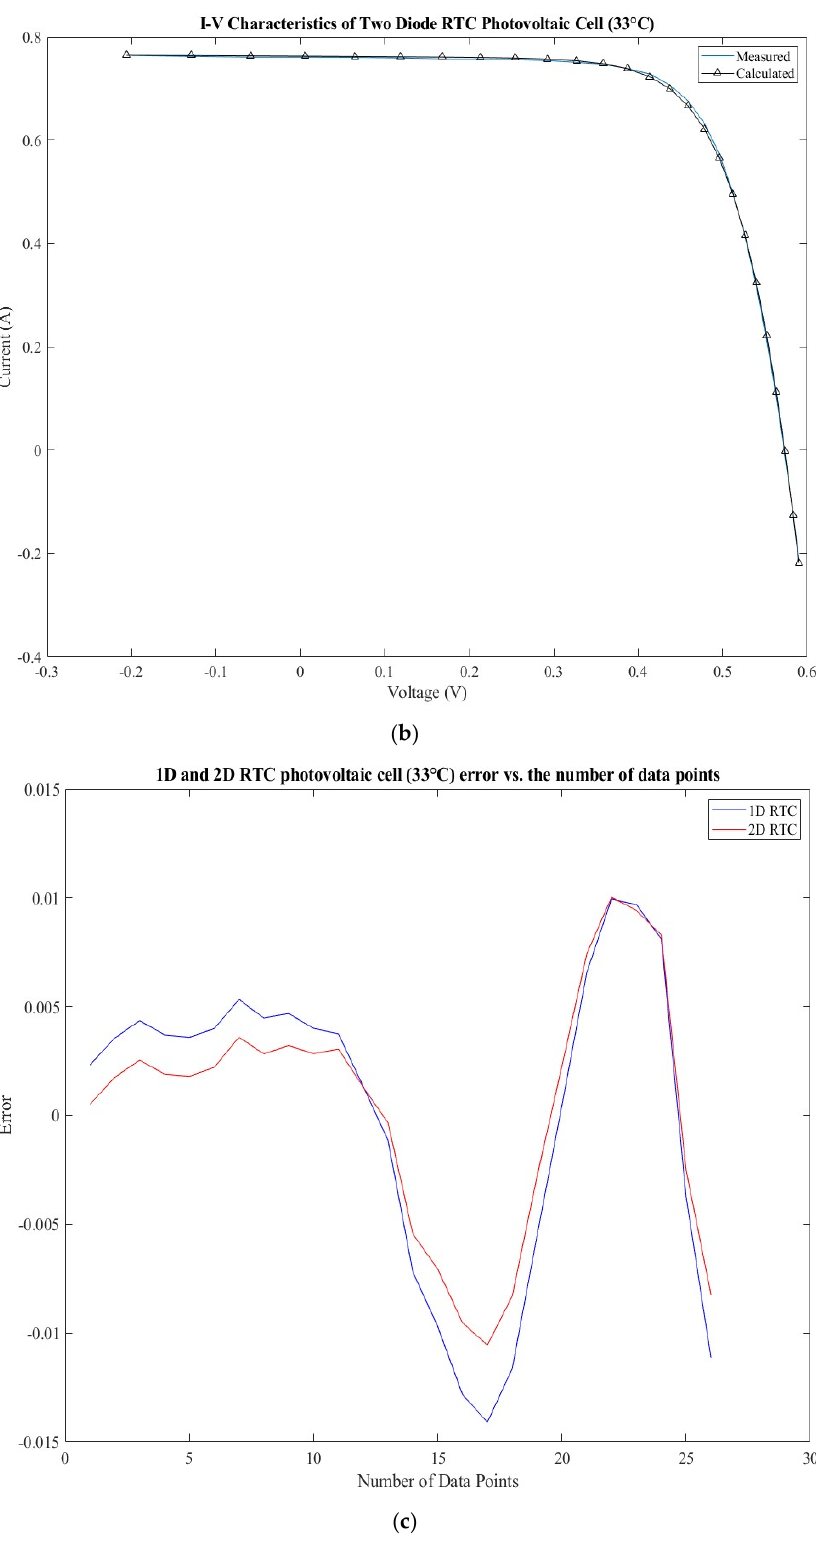
Figure 4 . RTC photovoltaic cell: ( a ) measured and calculated I-V characteristic for SDM; ( b ) measured and calculated I-V characteristic for DDM; ( c ) SDM and DDM errors comparison .